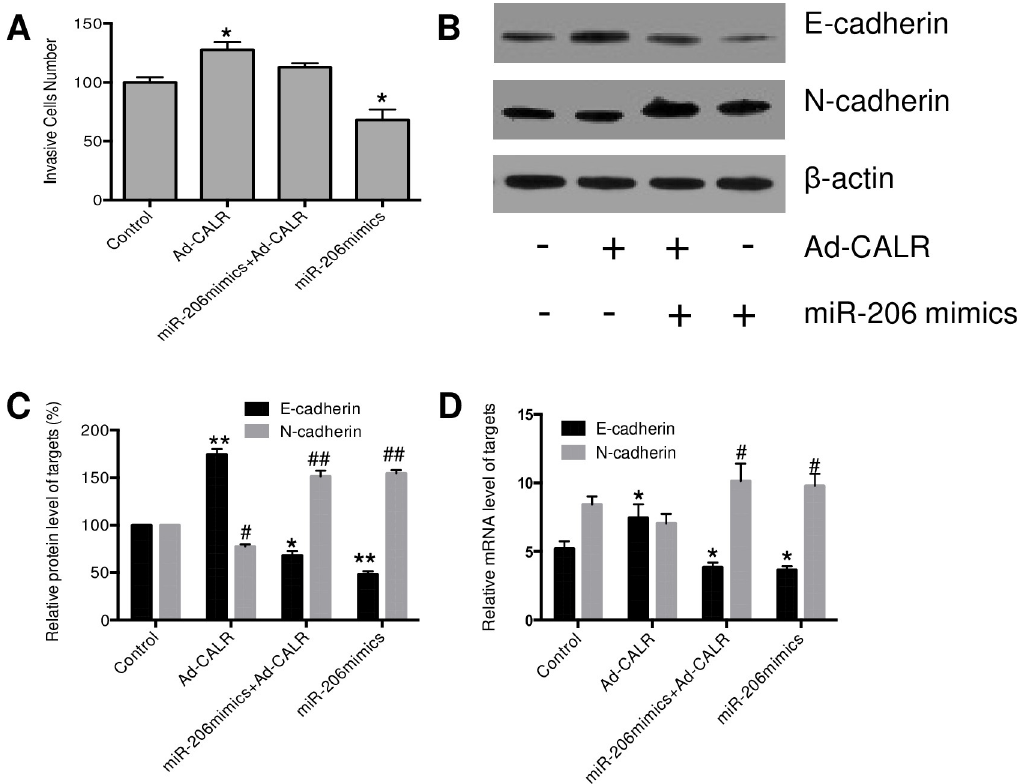
Fig 3. Effect of miR-206 on CALR-mediated metastasis of human breast cancer stem cells. Cells were treated with miR-206 mimics, miR-206 mimics+Ad-CALR and Ad-CALR for 48 h, respectively. (A) invasive breast cancer stem cells were counted; (B&D), CALR protein expression was measured by Western blotting analysis; C, CALR gene was measured by real-time quantitative PCR. All results are expressed as the mean ± S.D. from three independent experiments, � P < 0 . 05 , �� P < 0 . 01; #P < 0 . 05 , ##P < 0 . 01 vs. control